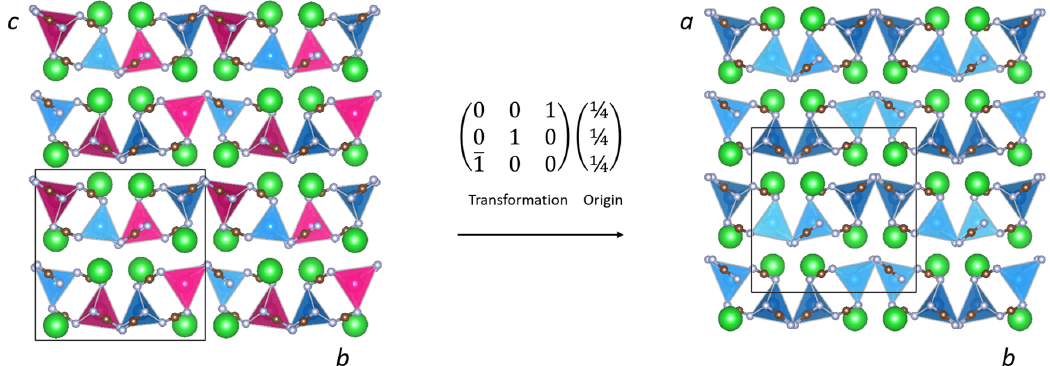
Figure 1. Comparison of the crystal structures of ( left ) LiBa 2 Al(NCN) 4 ( P 2 1 2 1 2 1 ), and ( right ) BaZn(NCN) 2 ( Pbca ).